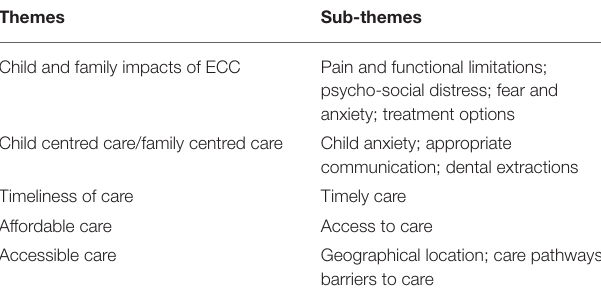
TABLE 1 | Elicited themes and